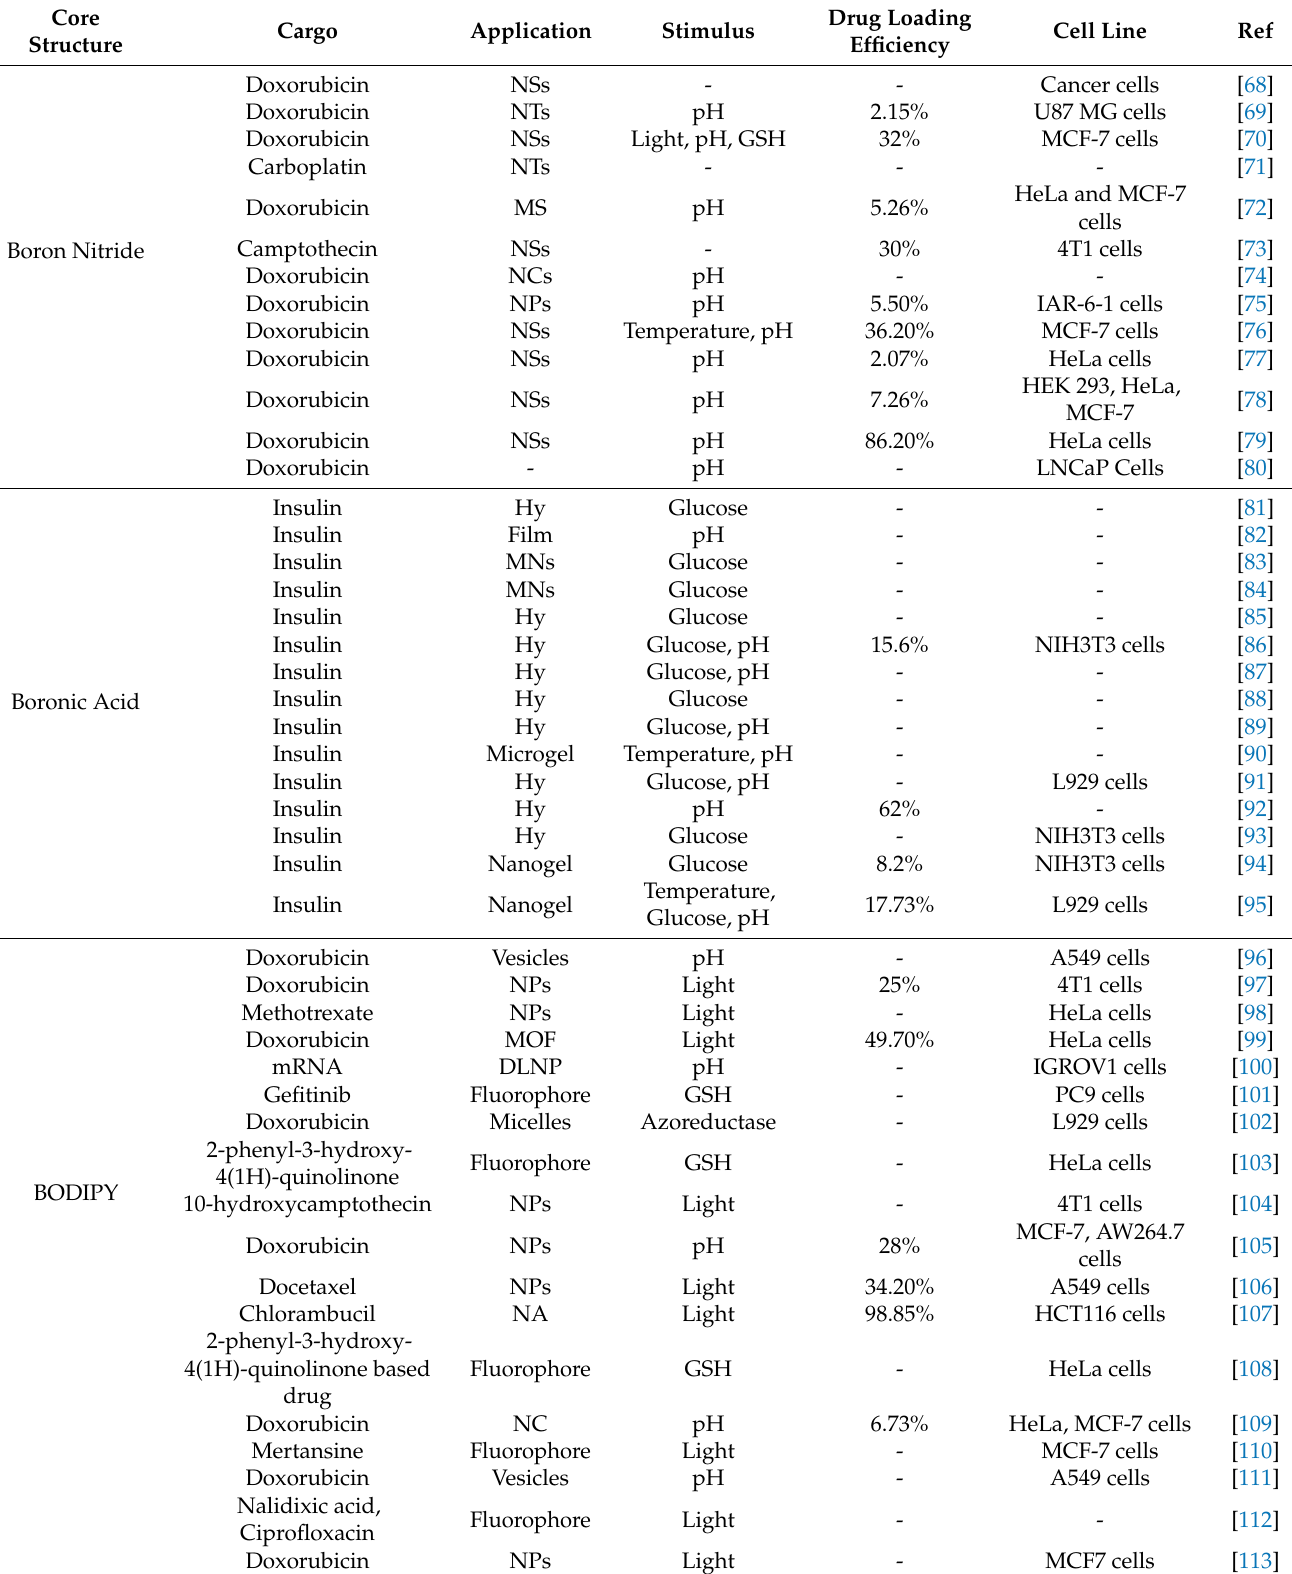
Table 1. Summary of boron-based drug delivery